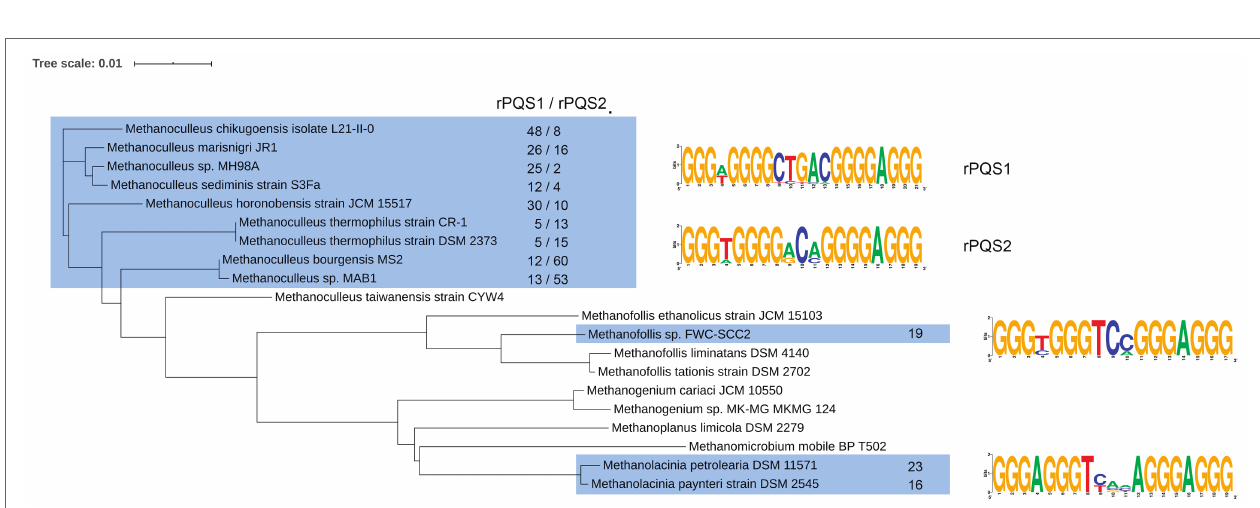
FIGURE 2 | Phylogenic tree for Methanomicrobiaceae family based on alignment of 16S rRNA with ClustalW. The strains marked in blue contain the rPQS, which consensus sequences are shown on the left. Total number of each consensus rPQS is shown for each marked